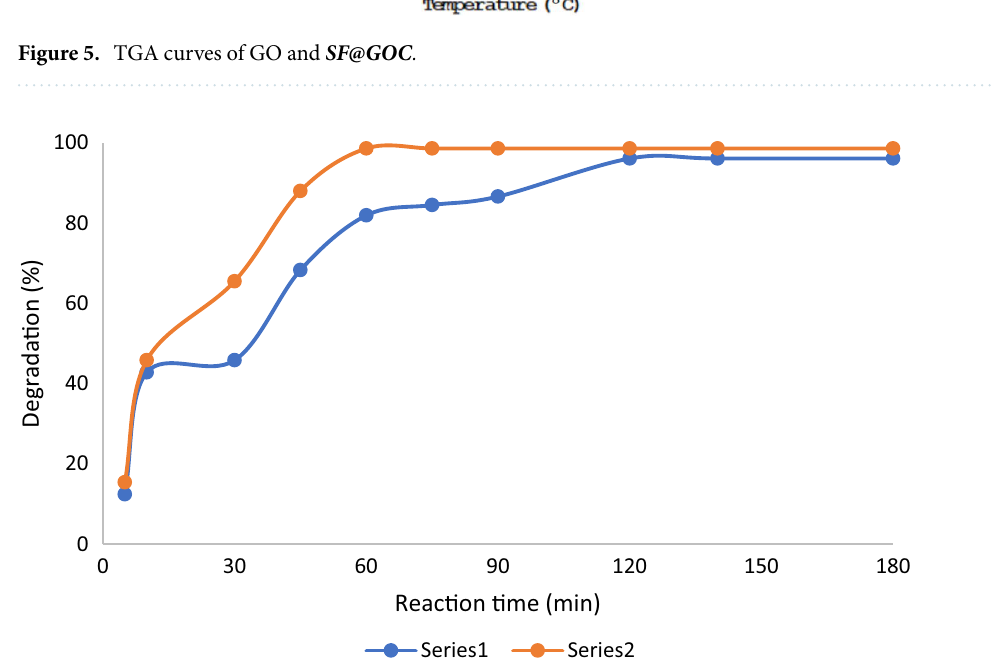
Figure 6. Effect of reaction time on Orange (II) (Series 1) and Eosin Y (Series 2)